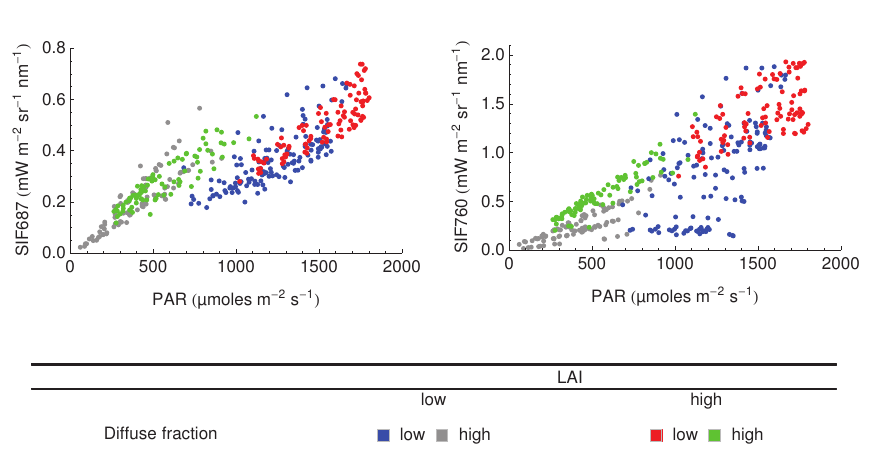
Figure 4. Relationship between PAR and sun-induced fluorescence (SIF) for different development stages and diffuse fractions of PAR ( f dif fPAR ). Two classes of LAI are represented: low—LAI ranges from approx. 0.8 to 6 (DOY from 62 to 119, blue and gray points); high—LAI is approx. 6 (DOY from 120 to 157, red and green points). Classes of diffuse fraction of PAR ( f dif fPAR ): low—clear sky days only, f dif fPAR ranges from 0.15 to 0.5; high— f dif fPAR ≥